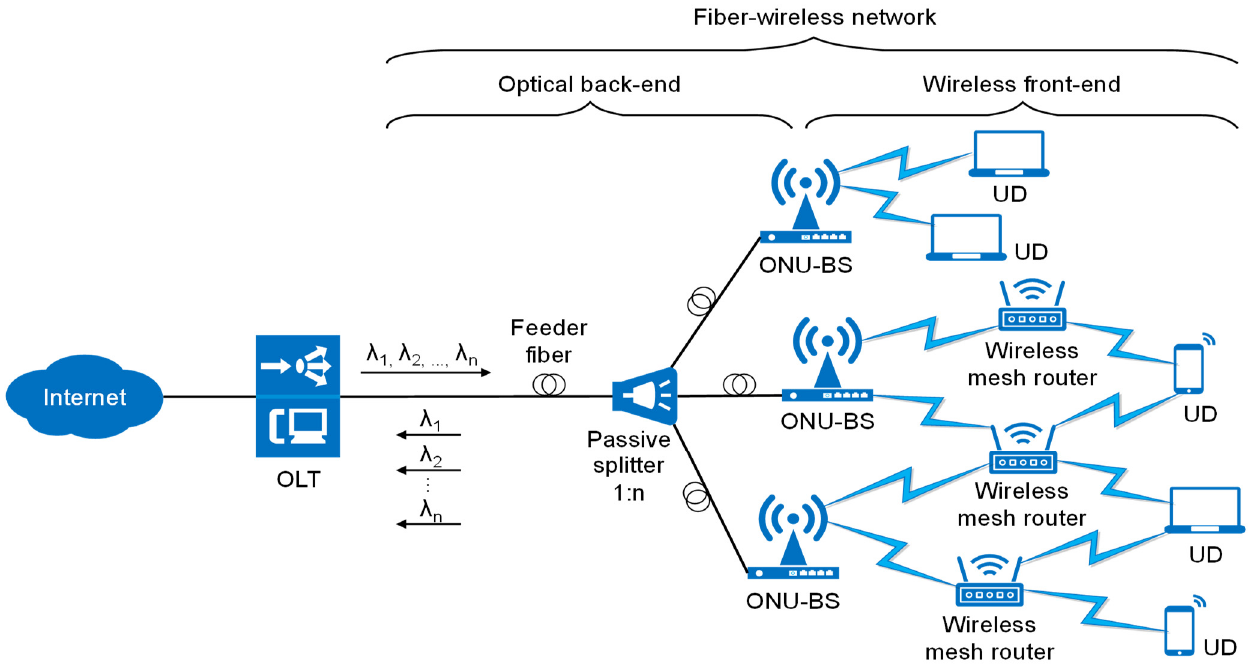
Figure 2. Illustration of R&F integration between optical and wireless networks.